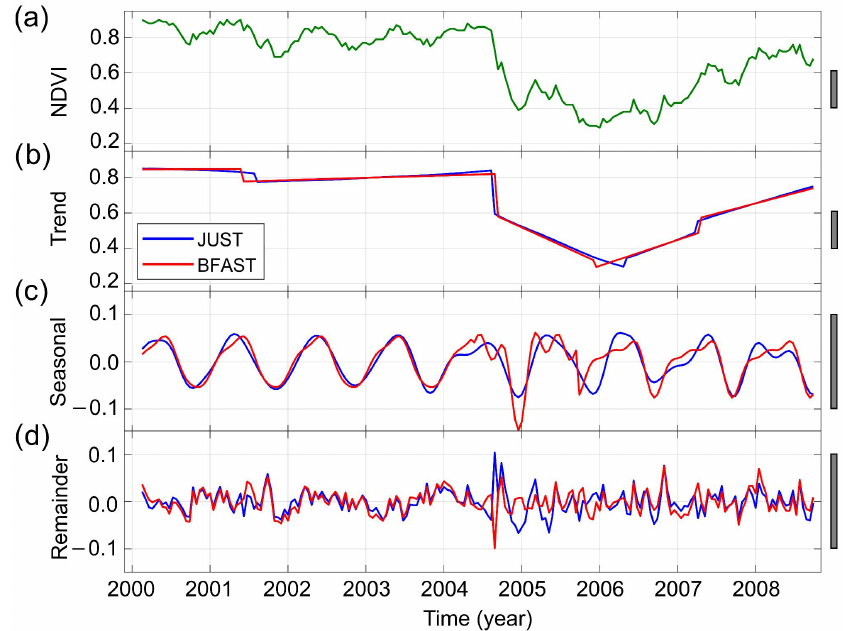
Figure 11. Decomposition of an equally spaced NDVI time series into trend, seasonal, and remainder components. ( a ) NDVI time series (harvest), and ( b – d ) the JUST and BFAST results for trend, seasonal, and remainder components, shown in blue and red, respectively. To help comparisons, the solid bars with the same data range are displayed on the right-hand side of the plot.